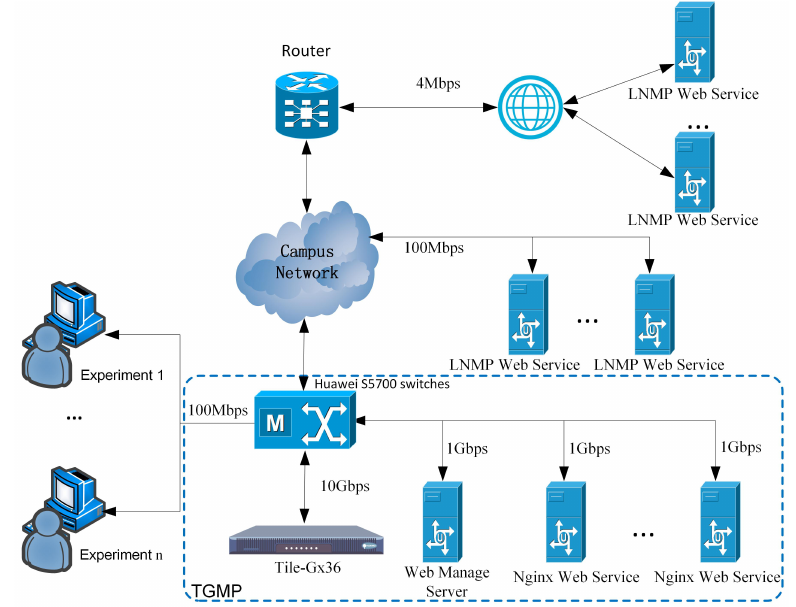
Figure 10. The deployment of the prototype